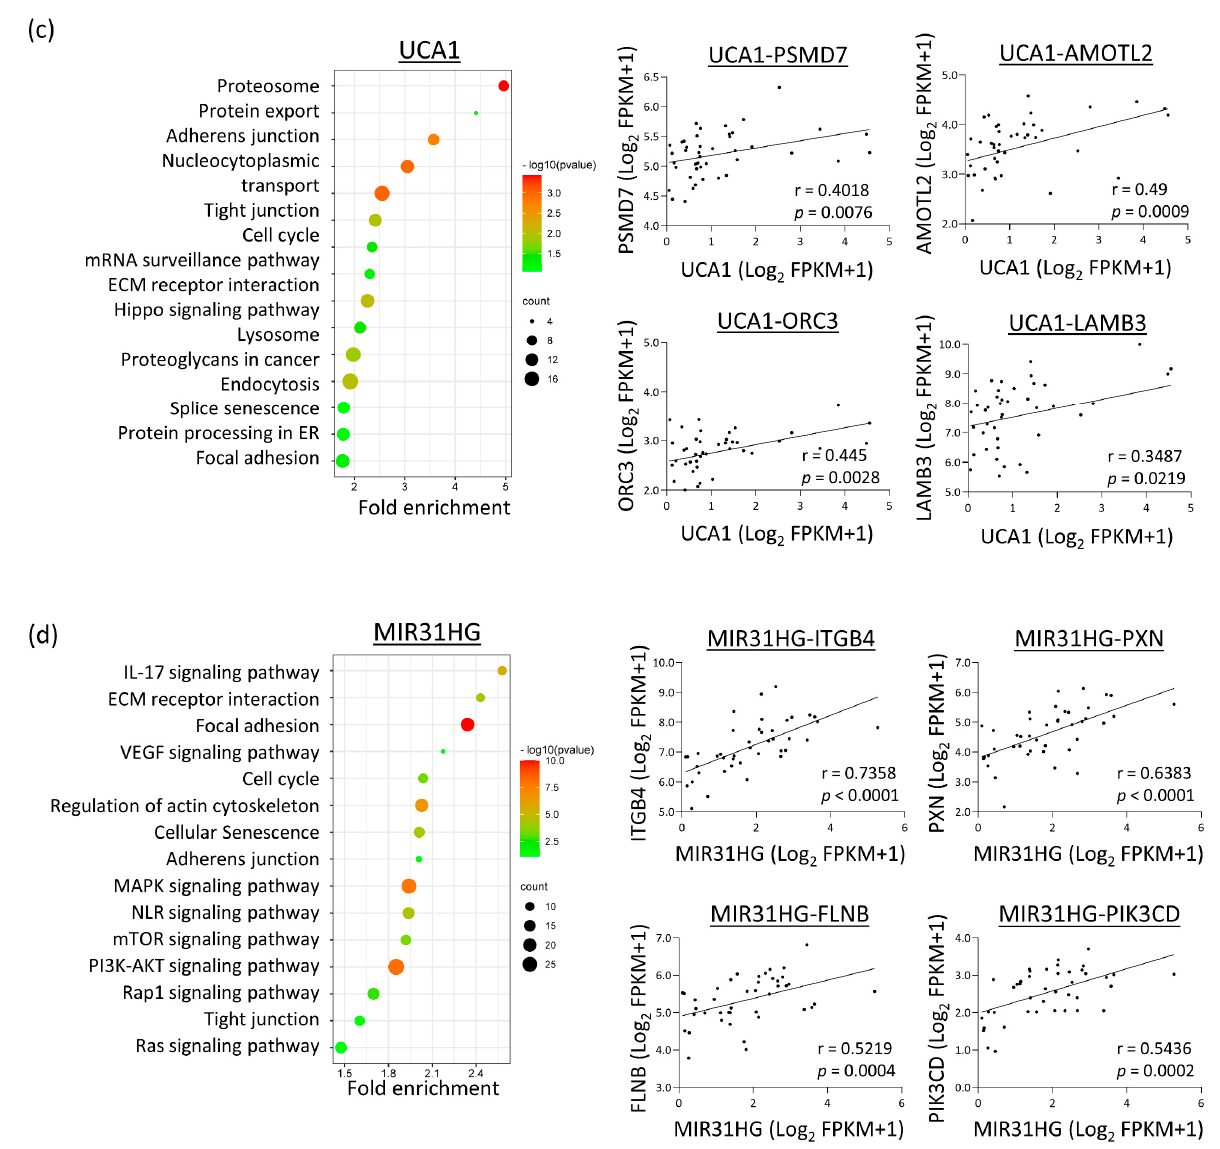
Figure 4. Functional pathways of LUCAT1, UCA1, and MIR31HG, as analyzed via in silico methods. ( a ) The flow chart represents the strategy to investigate the potential functions of lncRNAs (LUCAT1, UCA1, and MIR31HG) through inquiry of the co-expression molecules (mRNAs) and analysis using the DAVID software. ( b ) The LUCAT1 enriched functional pathways and examples of correlative genes. ( c ) The UCA1 enriched functional pathways and examples of correlative genes. ( d ) The MIR31HG enriched functional pathways and examples of correlative genes.